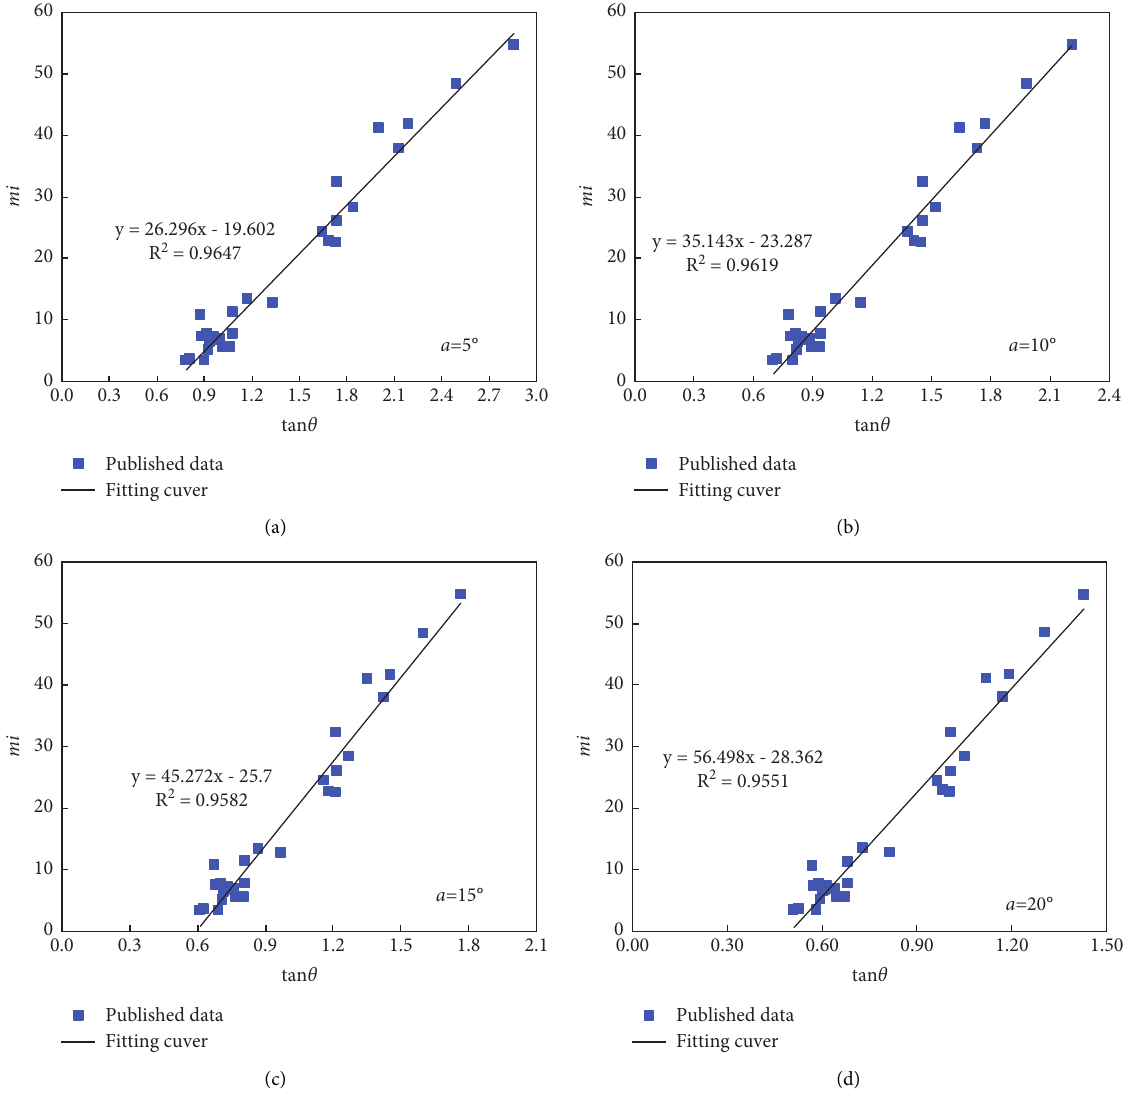
Figure 3: A linear relationship between the contact friction coefficient and the parameter m